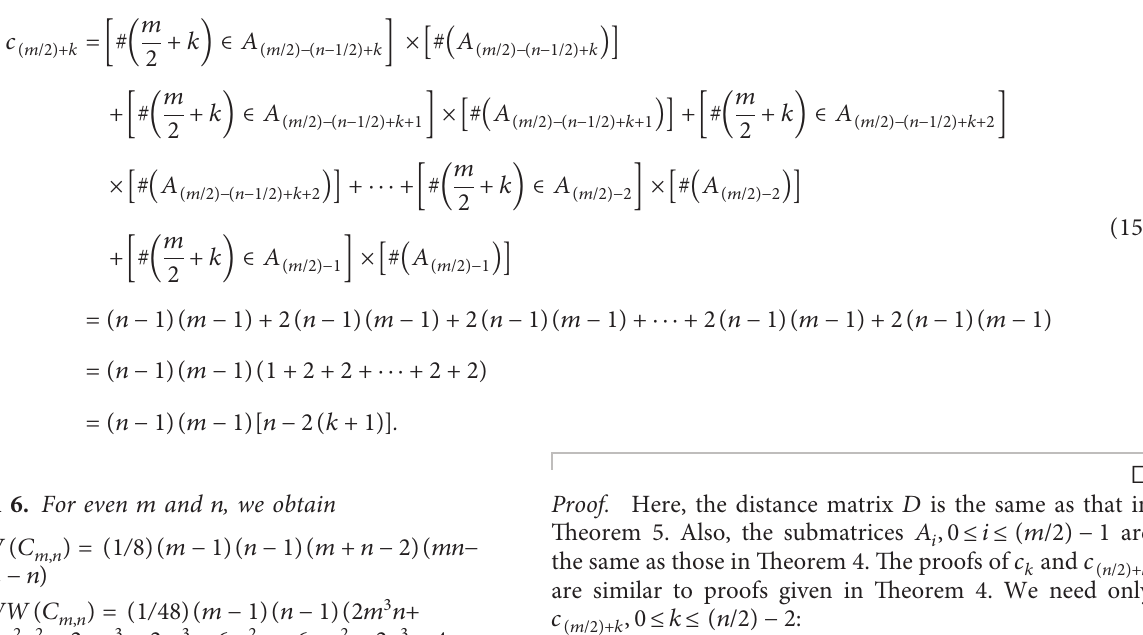
Figure 11: (a) Wiener index and (b) hyper-Wiener index for even m and n